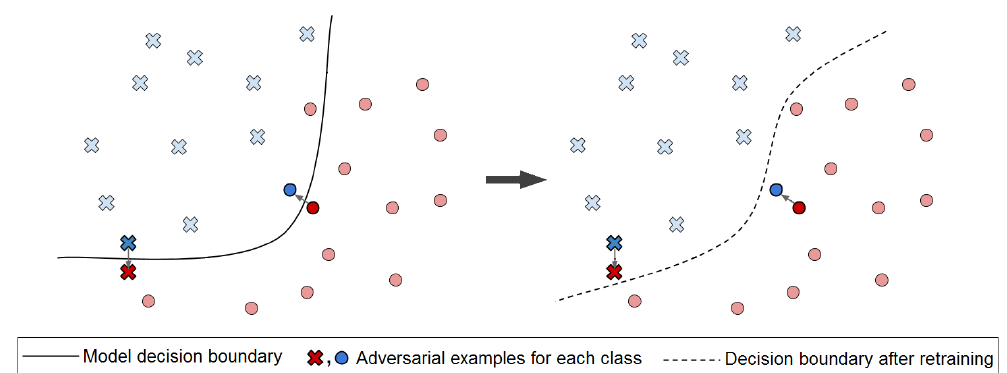
Figure 4. In retraining the defensive approach the victim model learns how to avoid mistakes by improving its decision boundaries.